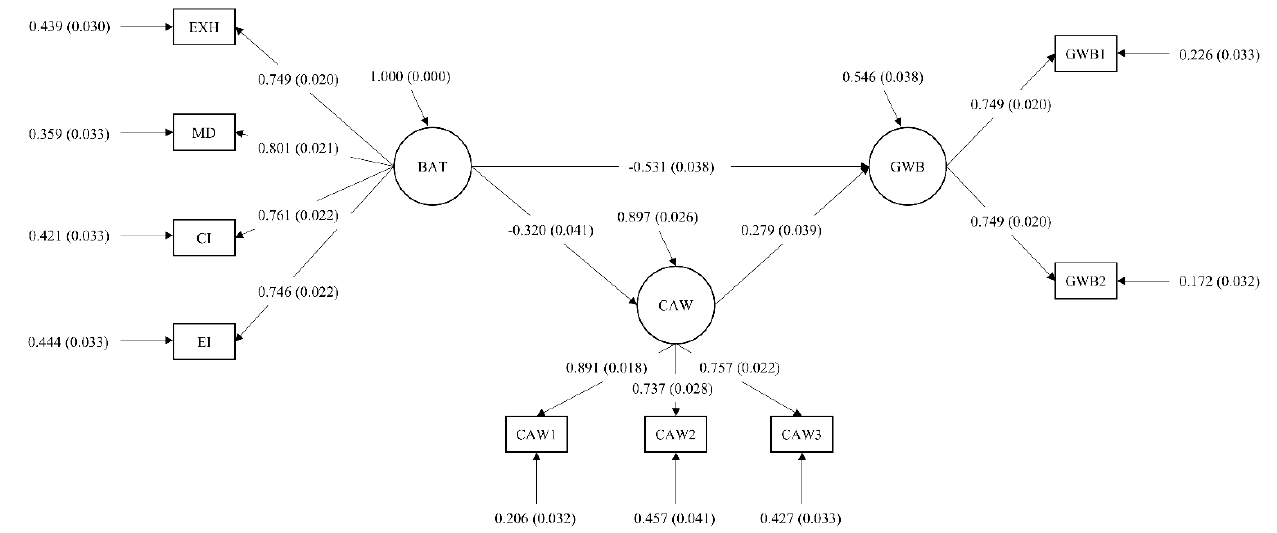
Figure 2. Final model. Results of the structural equation model. Standardized effects and significance